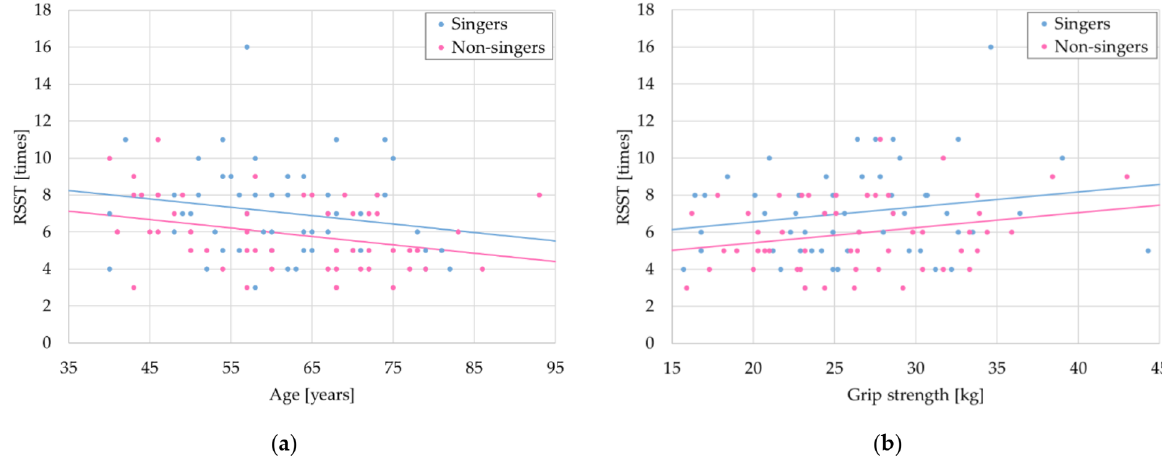
Figure 3. ANCOVA of RSST score: ( a ) ANCOVA of age plotted as a function of RSST score, RSST = − 0.045 × Age + 9.837 − 1.122 × Group (Singers: Group = 0, Non-singers: Group = 1, p = 0.0084); ( b ) ANCOVA of grip strength plotted as a function of RSST score, RSST = 0.081 × Grip strength + 4.931 − 1.124 × Group (Singers: Group = 0, Non-singers: Group = 1, p =